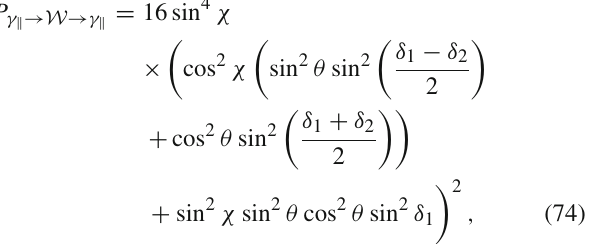
In the case of non-degenerate resonance, the probability